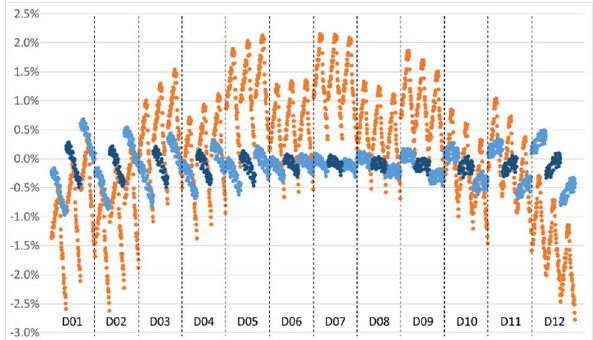
Figure 18 : Time delays error assessment computed on B2-B4, sorted by detectors, column number, and latitude. Orange: ESA handbook table. Blue: proposed L1C estimation. Dark blue: detectors’ center.